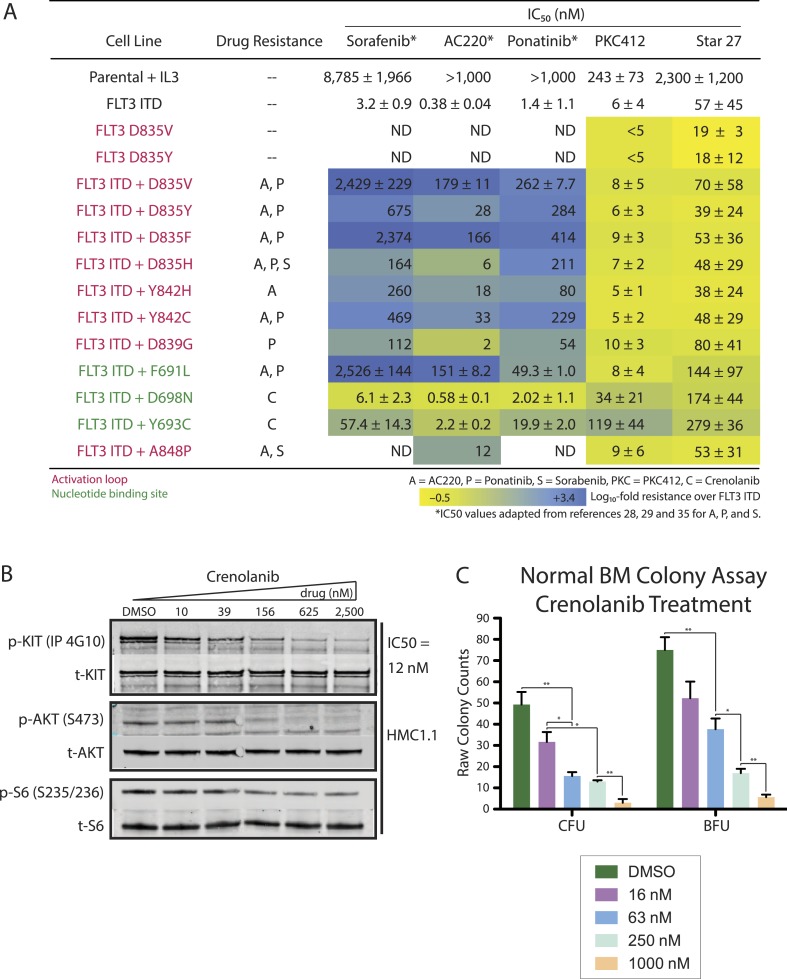
Heatmap of cellular EC50 values for leading clinical therapies (S = Sorafenib, A = AC220, P = Ponatinib, PKC412) and Star 27 against a panel of AML-relevant human- and mouse-derived drug-resistant cell lines.(A) (adapted from Guo et al., 2007; Kampa-Shittenhelm et al., 2013; Smith et al., 2013). Log10-scale fold resistance between Ba/F3 FLT3 ITD and drug-induced mutations (ITD + KD double mutant) shown via heat map. Point mutations corresponding to each drug-relevant resistance shown. Star 27 maintains potency between FLT3 ITD and resistance mutants comparable to PKC412. Mutations derived independently from both saturating mutagenesis and patient-derived samples [Smith et al., 2012]. Replicates shown are the result of at least two or three attempts, each in triplicate, and error ranges represent the standard error of the mean. (B and C) Crenolanib's effect on p-KIT inhibition and of colony growth in normal BM. (B) Crenolanib inhibits p-KIT in HMC1.1 cells at 12 nM IC50. This level of inhibition translates to downstream kinases, with inhibition of p-AKT (S473) and p-S6 (S235/S236). (C) Crenolanib potently inhibits normal BM colony formation at <63 nM and ca. 63 nM IC50's of CFU and BFU colonies, respectively.